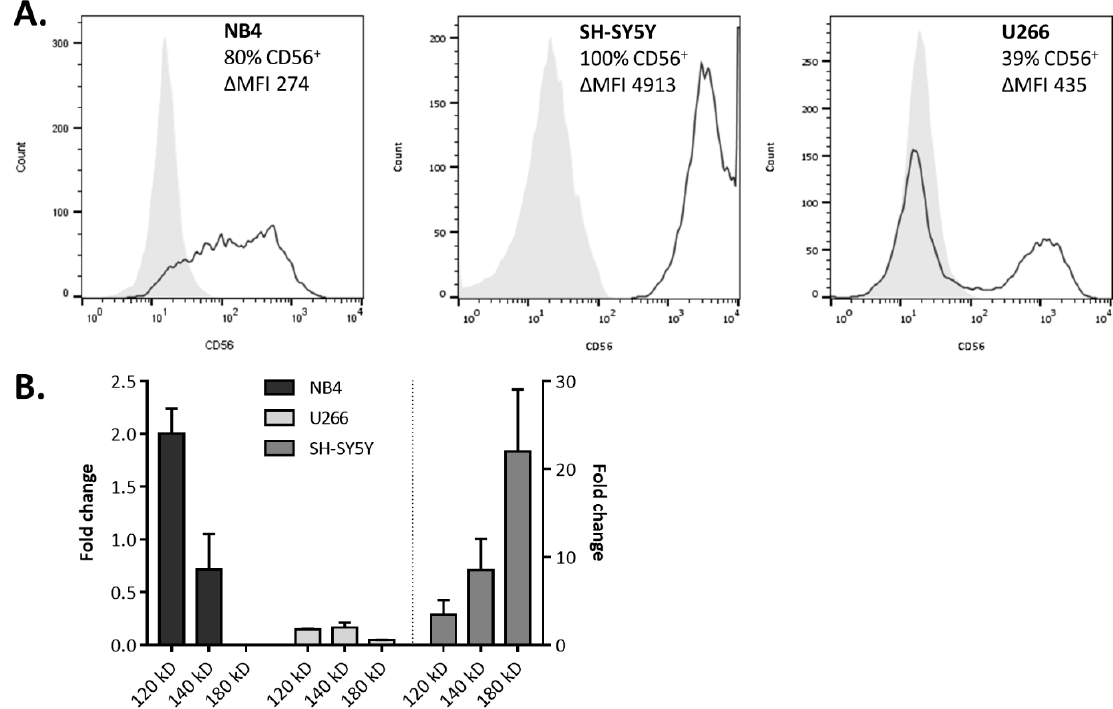
Figure 2. Cluster of di ff erentiation (CD)56 expression by human tumor cell lines. ( A ) Flow cytometric analysis of tumor cells labelled with CD56-PE (black line) or corresponding isotype control (filled grey), represented as histogram overlays. ( B ) Real-time qPCR data of the expression levels of the different CD56 isoforms by NB4, U266 (left y -axis) and SH-SY5Y (right y -axis). Fold-changes are scaled to average. Each bar is the mean ± standard error of the mean (SEM) of technical replicates ( n = 2).